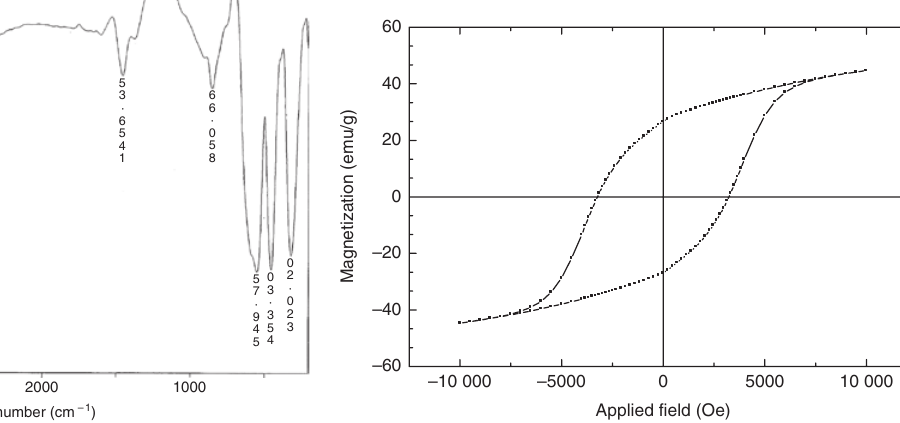
Figure 12: Room temperature hysteresis loop achieved at 850 °